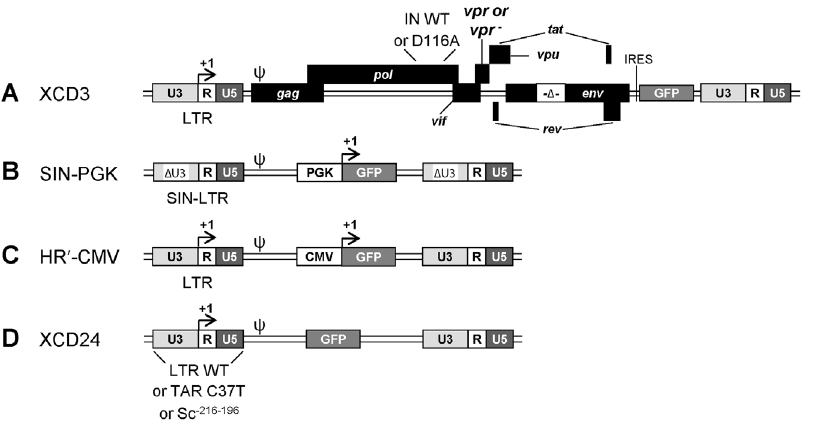
Figure 1. Design of lentiviral vectors. ( A ) Schematic representation of the lentiviral (LV) vectors (in the proviral, integrated form) used in this study. XCD3 is a human immunodeficiency virus type 1 (HIV-1) construct lacking the envelop ( env ) and negative factor ( nef ) genes and carrying the green fluorescent protein ( gfp ) transgene under the control of the native HIV-1 long terminal repeat (LTR) and an internal ribosome entry site (IRES) (also referred as to HIV-1 env - nef - IRES- gfp ). Two derived versions of this vector have been engineered, the first presenting the deletion of Vpr ( vpr - ) and the second the D116A mutation in the integrase (IN) coding sequence [named XCD3 vpr - and XCD3 IN(D116A), respectively]. ( B ) SIN-PGK is a self- inactivating (SIN, i.e. , U3-deleted, D U3) LV vector containing the gfp under the control of the human phosphoglycerate kinase (PGK) internal promoter. ( C ) HR’-CMV is an LV vector carrying the gfp transgene under the control of both the immediate early human cytomegalovirus (CMV) and HIV-1 promoters. ( D ) XCD24 is an LV vector lacking all HIV-1 genes and carrying the gfp under the control of the wild-type (WT) HIV-1 promoter. Two variants of this vector have been produced, the first mutated in the putative Ku binding site [KBS, XCD24 Sc -216-196 ] and the second in the trans - activation response (TAR) element [XCD24 TAR(C37T)]. y , encapsidation